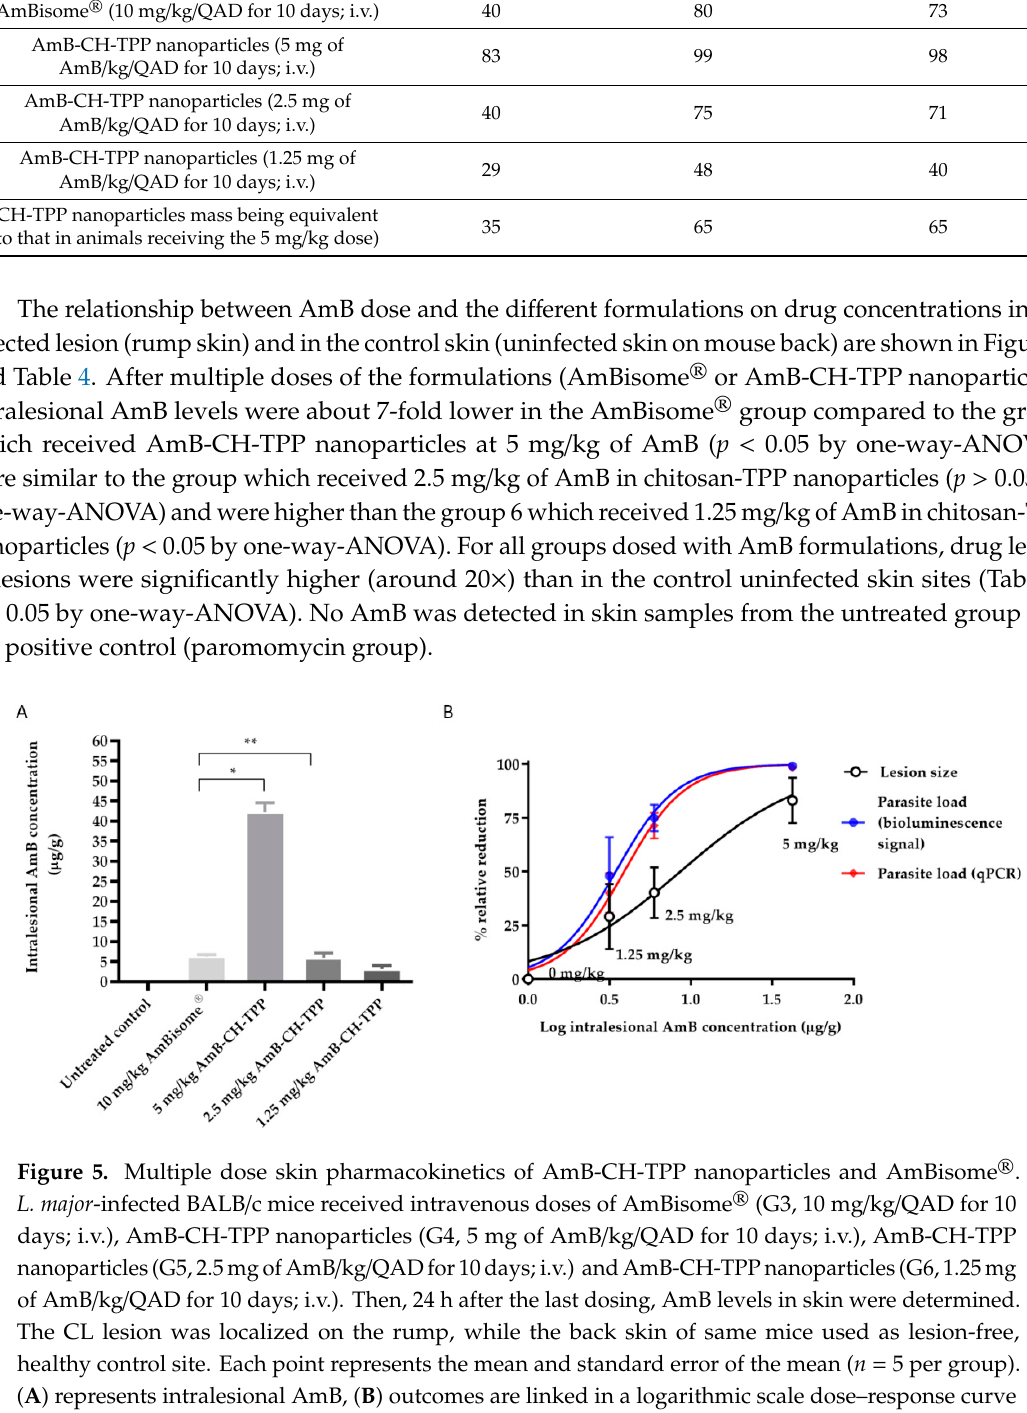
Table 3. Reduction lesion size and parasite load measured using bioluminescence and qPCR in treated groups compared to untreated group. % Reduction of % Reduction of Parasite % Reduction of Parasite Compounds Lesion Sizes Load (Bioluminescence) Load (qPCR) paromomycin (50 mg / kg / QD for 10 days; i.p.) 89 99 99 AmBisome ® (10 mg / kg / QAD for 10 days; i.v.)